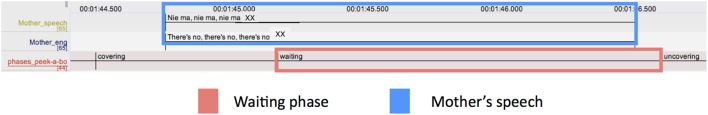
Detail from ELAN transcript. The blue box marks the mothers' speech and the red box the waiting phase of the peekaboo structure.